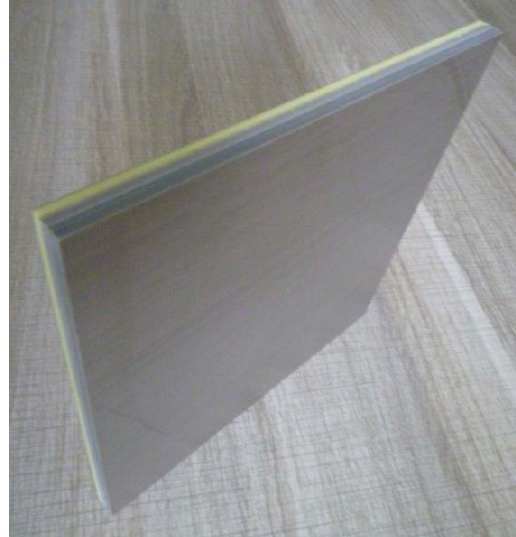
Figure 4. Prototype of the manufactured absorber.